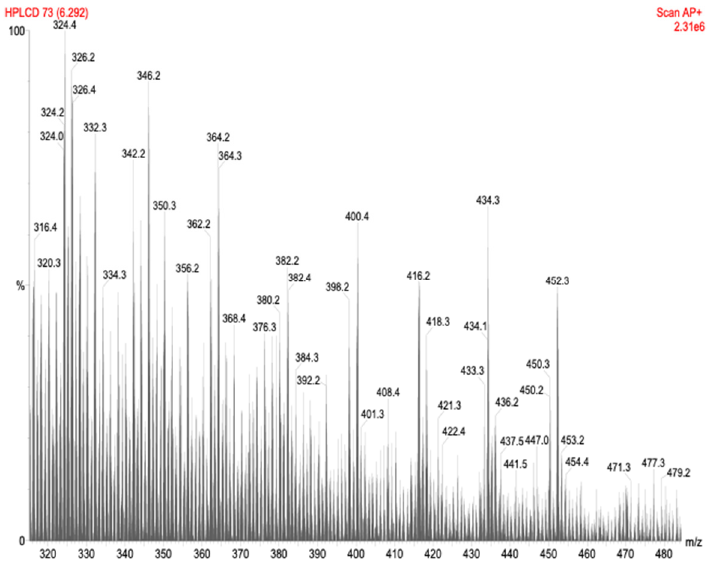
Figure 4. APCI-MS spectra of the bioactive fraction after HPLC separation. A consistent peak separation of 18 Daltons is observed.